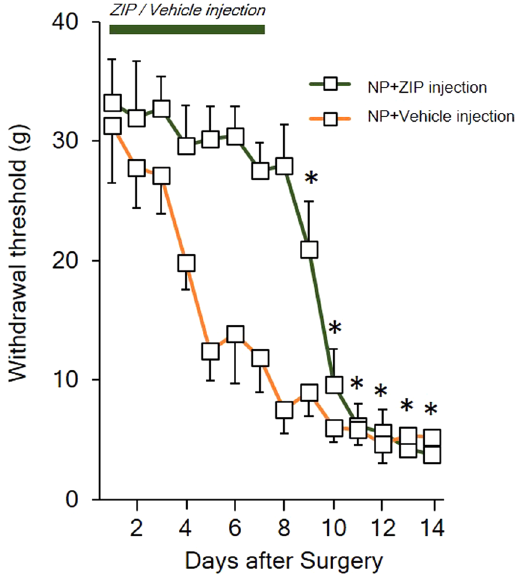
Figure 5. The effect of ZIP injections on the initial stage of neuropathic pain. To evaluate the effects of ZIP on the initial state of neuropathic pain, ZIP was injected into the ACC after neuropathic surgery. ZIP-injected rats showed a normal mechanical threshold up to 7 days after surgery. However, after the completion of the ZIP injection, the mechanical threshold decreased rapidly, which resulted in the development of neuropathic